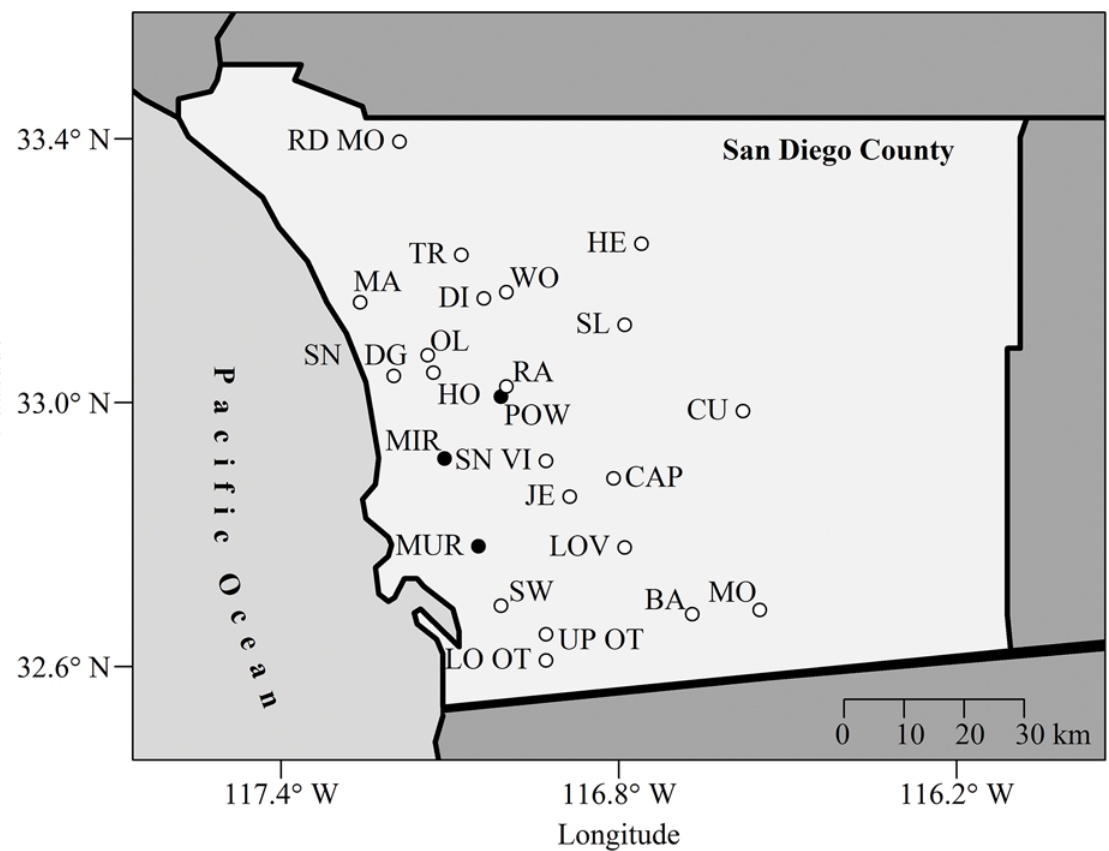
Fig 1. Twenty-four major reservoirs in San Diego County, California, USA http://www.sdcwa.org/san-diego-county-water-sources (http://www. sdcwa.org/reservoirs). Barret (BA); Cuyamaca (CU); Dixon (DI); El Capitan (CAP); Henshaw (HE); Hodges (HO); Jennings (JE); Loveland (LOV); Lower Otay (LO); Maerkle (MA); Miramar (MIR) ; Morena (MO); Murray (MUR) ; Olivenhain (OL); Poway (POW) ; Ramona (RA); Red Mountain (RD MO); San Dieguito (SN DG); San Vicente (SN VI); Sutherland (SL); Sweetwater (SW); Turner (TR); Upper Otay (UP OT); Wohlford (WF). The black points indicate the three reservoirs we